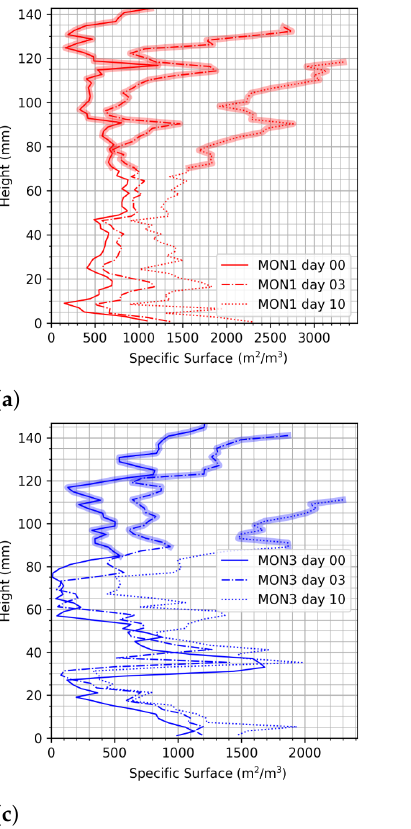
Figure 7. Specific Surface Areas (SSA) profiles. The deposit layer is represented by a wider trace in the curves. Computations were performed for a ROI of 60%. ( a ) MON1, ( b ) MON2, ( c ) MON3. The average SSA is greater in the deposit layer than in the gravel layer (Table